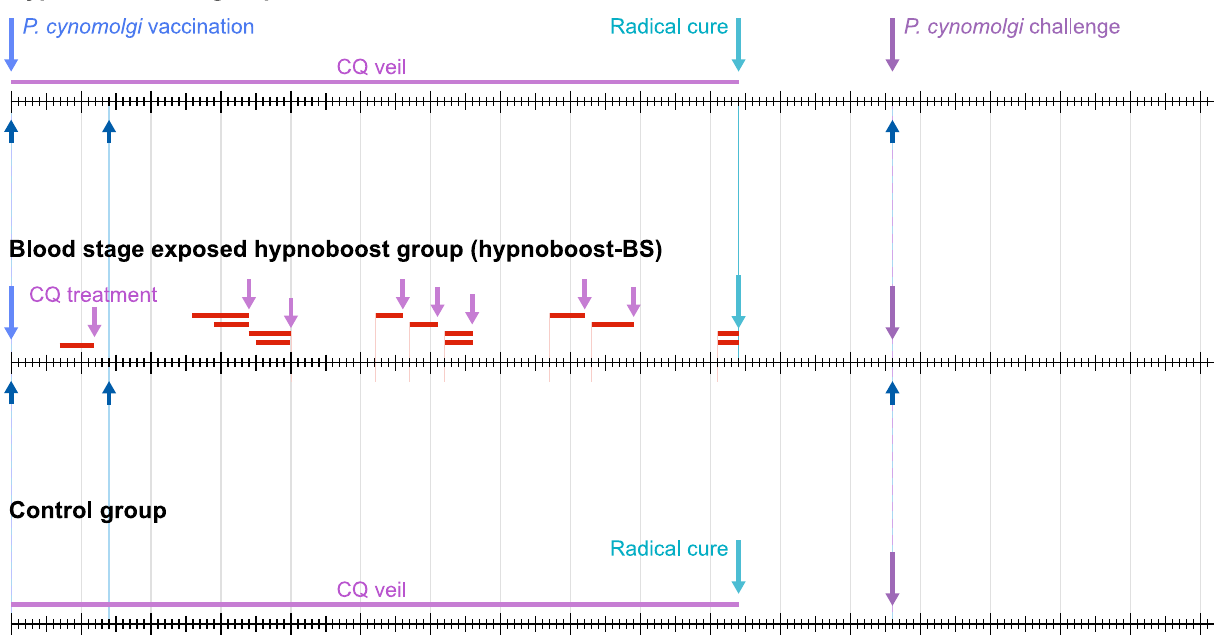
Fig. 1 Hypnoboost concept and experimental set-up. a The hypnoboost concept consists of a single-shot high-dose relapsing malaria sporozoite vaccination to induce and boost liver-stage immune responses (orange background bars), while aborting blood-stage infection by continuous chloroquine treatment. Following liver-stage parasite clearance (primaquine (PQ) treatment) after three relapses, immunity should be high enough to protect from sporozoite challenge. b The hypnoboost concept was tested using three groups of rhesus macaques ( n = 4): a hypnoboost-CPS group, a blood-stage exposed hypnoboost-BS group and a control group. Light blue arrows: vaccination with 10 6 P. cynomolgi sporozoites. Lila lines: chloroquine (CQ) coverage established by weekly CQ injections. Lila arrows: start of 5-day CQ treatment. Red lines: duration of blood-stage parasitemia in the four animals of the hypnoboost-BS group. Teal arrows: start of radical cure treatment (5-day CQ and 7-day primaquine). Purple arrows: challenge with 200 P. cynomolgi sporozoites. Dark blue arrows: bleeding time points.